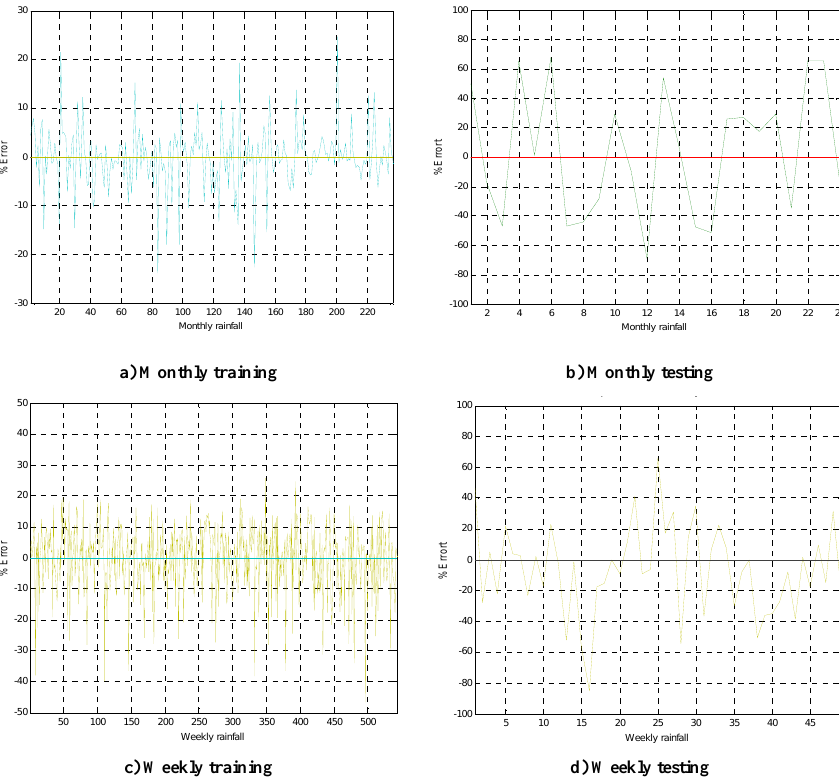
Fig. 13. Performance of the MLP-NN model for monthly and weekly rainfall forecasting during training and testing stages. MLP-NN; however, the RE level is improved for the